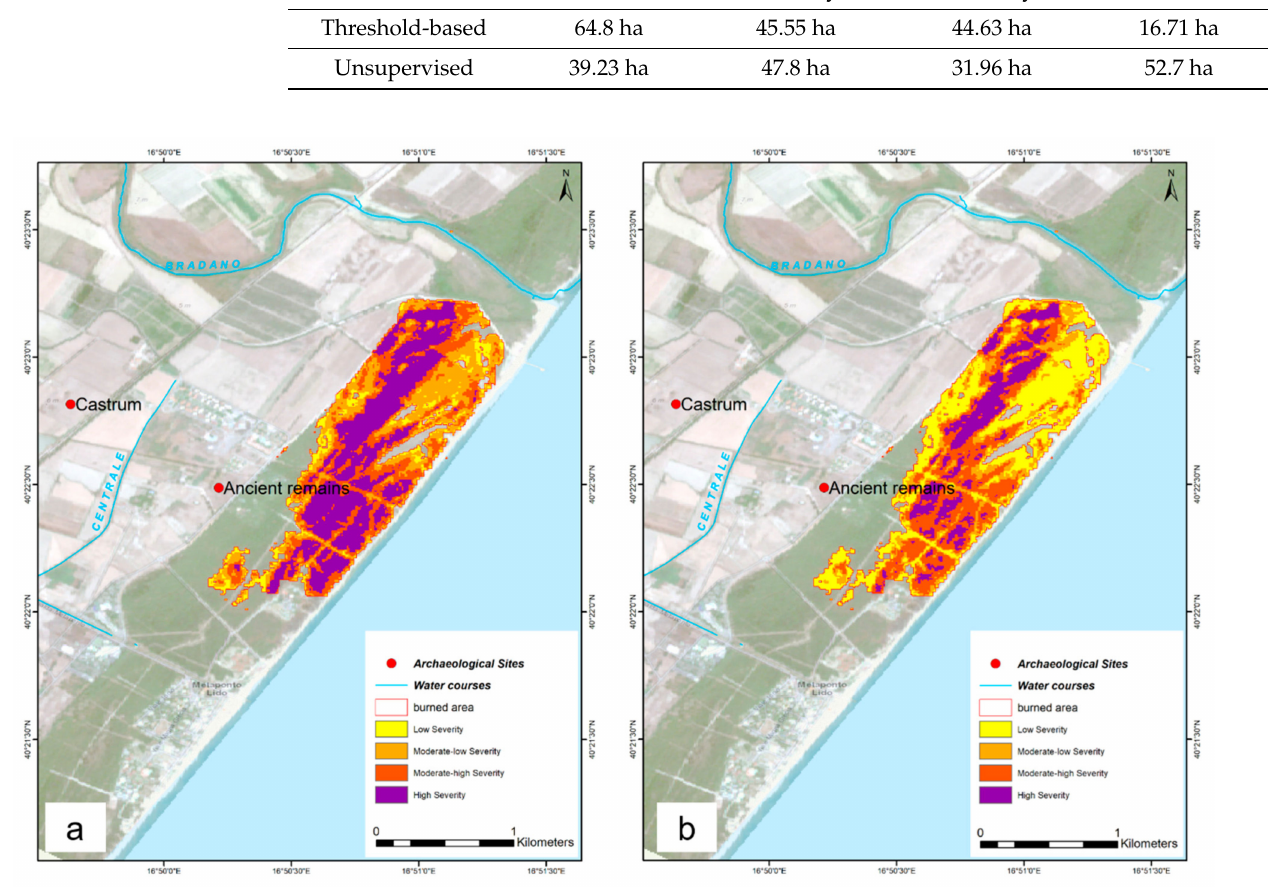
Figure 14. ( a ) S-2 threshold-based classification; ( b ) S-2 Unsupervised